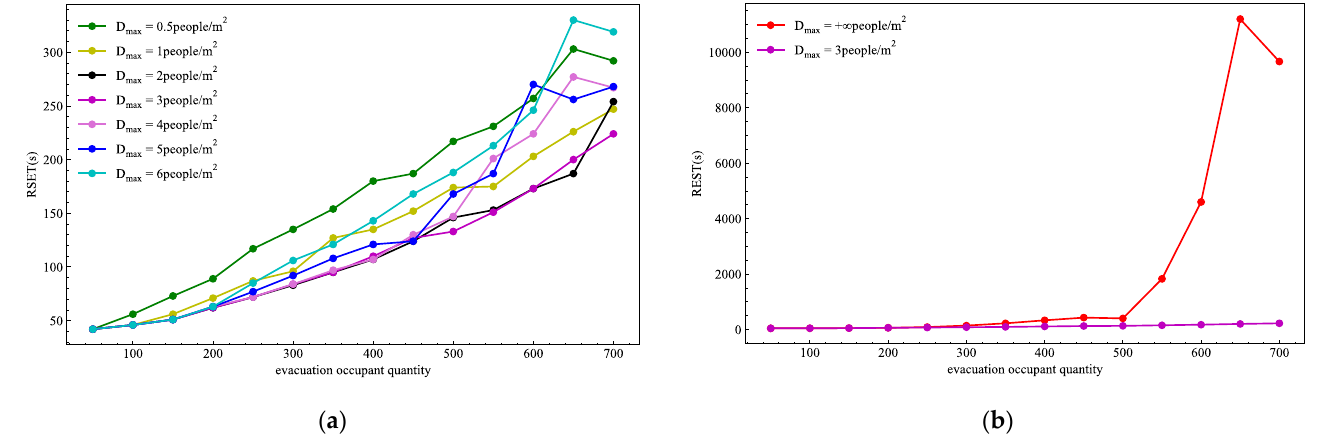
D between RSET and the number of Figure 13. The relationship corresponding to different max Figure 13. The relationship corresponding to different D max between RSET and the number of D on RSET; ( b ) The polyline is evacuees. ( a ) The polyline is about the influence of different evacuees. ( a ) The polyline is about the influence of different D max on RSET; ( b ) The polyline is about max 3 people / m = D and no path capacity constraints on RSET. about the influence of 2 the influence of D max = 3people/m 2 and no path capacity constraints on RSET. max